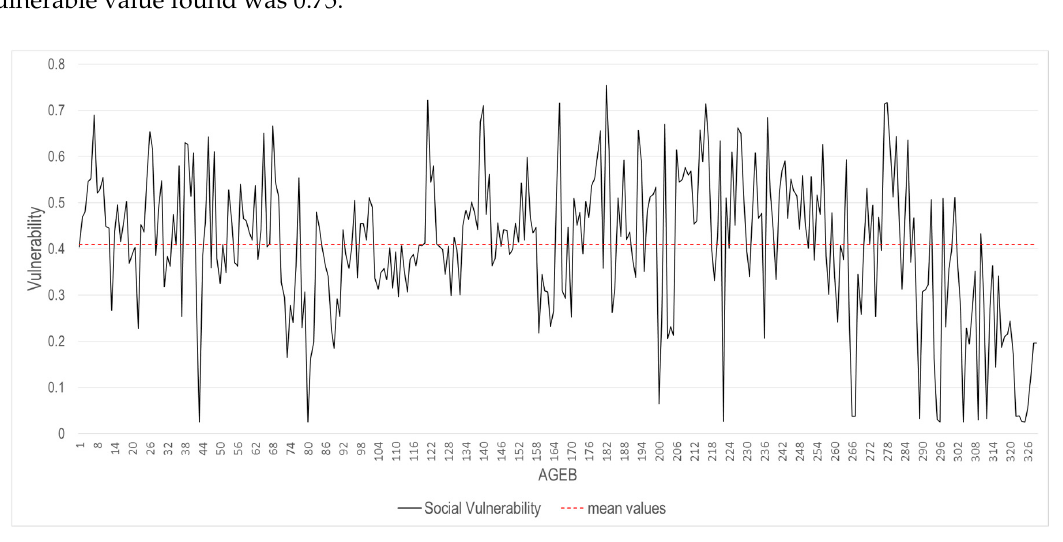
Figure 4. Spatial distribution of the AGEBS with a social vulnerability above the average value.